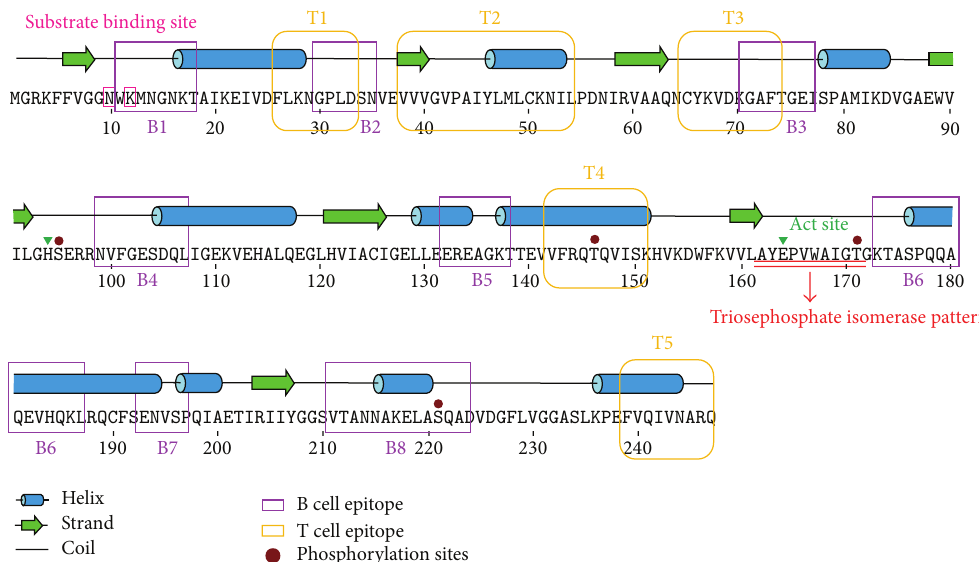
Figure 2: Sequences and second structure analysis of Der f 25 allergen. Ten 𝛼 -helices and seven 𝛽 -sheets were identified in Der f 25.